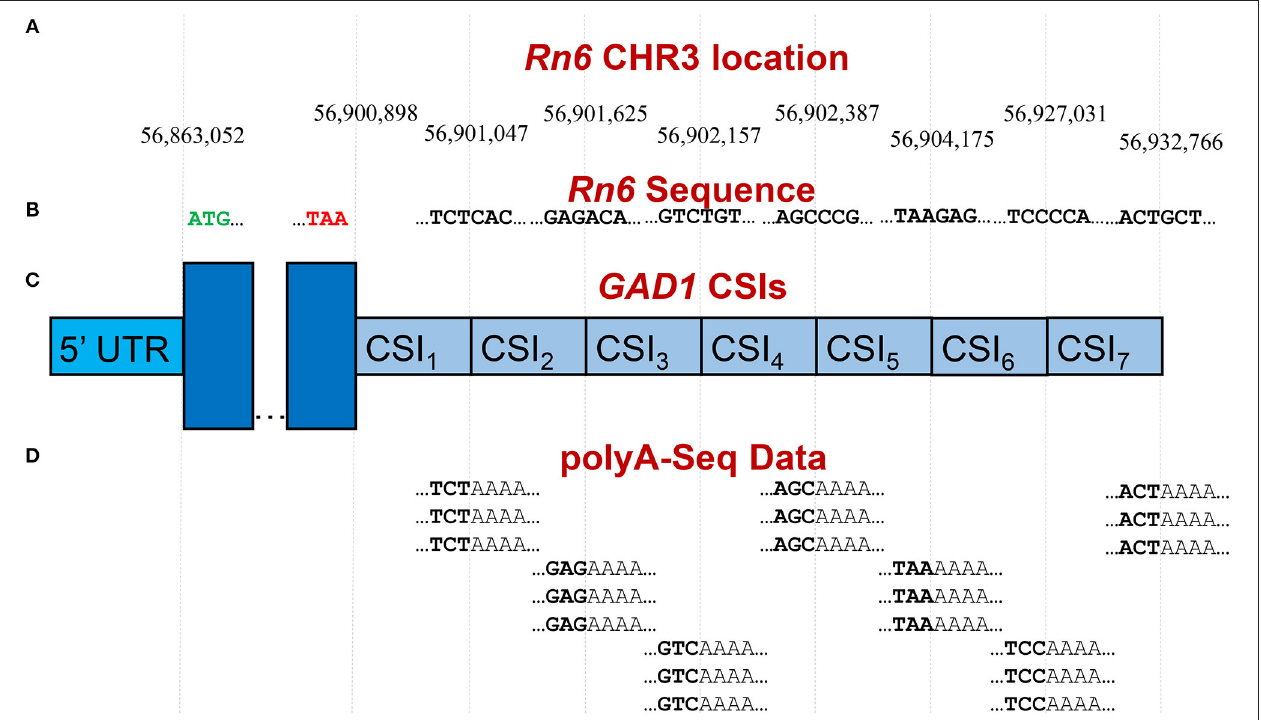
FIGURE 3 | Example of CSI structure for the GAD1 gene based on the rat Rn6 assembly. (A) Key chromosomal locations on Rn6 chromosome 3, including cleavage site locations (indicating CSIs) (not to scale). (B) Rn6 reference genome sequence at boundary locations. (C) Structure of the seven CSIs identified in the 3 ′ UTR region of GAD1 by CSI-UTR, based on polyA-Seq data. (D) Example polyA-Seq reads showing polyA sequences at cleavage sites. Based on the evidence of cleavage sites provided by the polyA-Seq data in (D) , CSI-UTR identifies seven cleavage site intervals (CSIs), beginning immediately after the distal most stop codon at position CHR3:56,90,898. CSI-UTR extends potential GAD1 transcripts to CHR3:56,932,766, well past the annotation provided by RefSeq entry NM_017007.1 which extends to